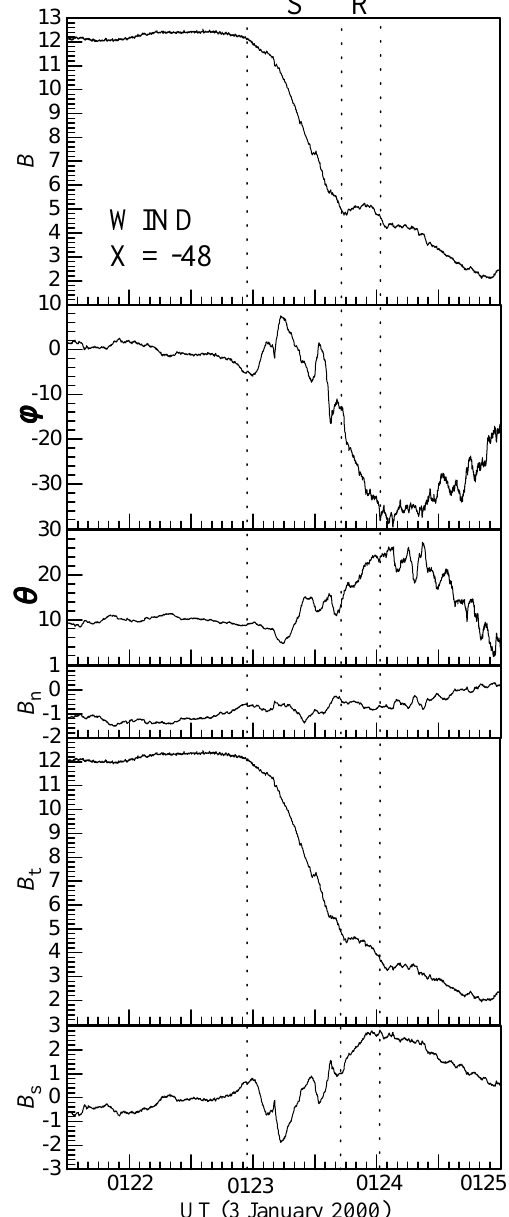
Fig. 10. A double discontinuity was observed on 2 January 2000 when the Wind spacecraft crossed the boundary surface entering the plasma sheet from the south lobe. This figure shows the mag- netic field structure of the double discontinuity observed from high- resolution Wind data.